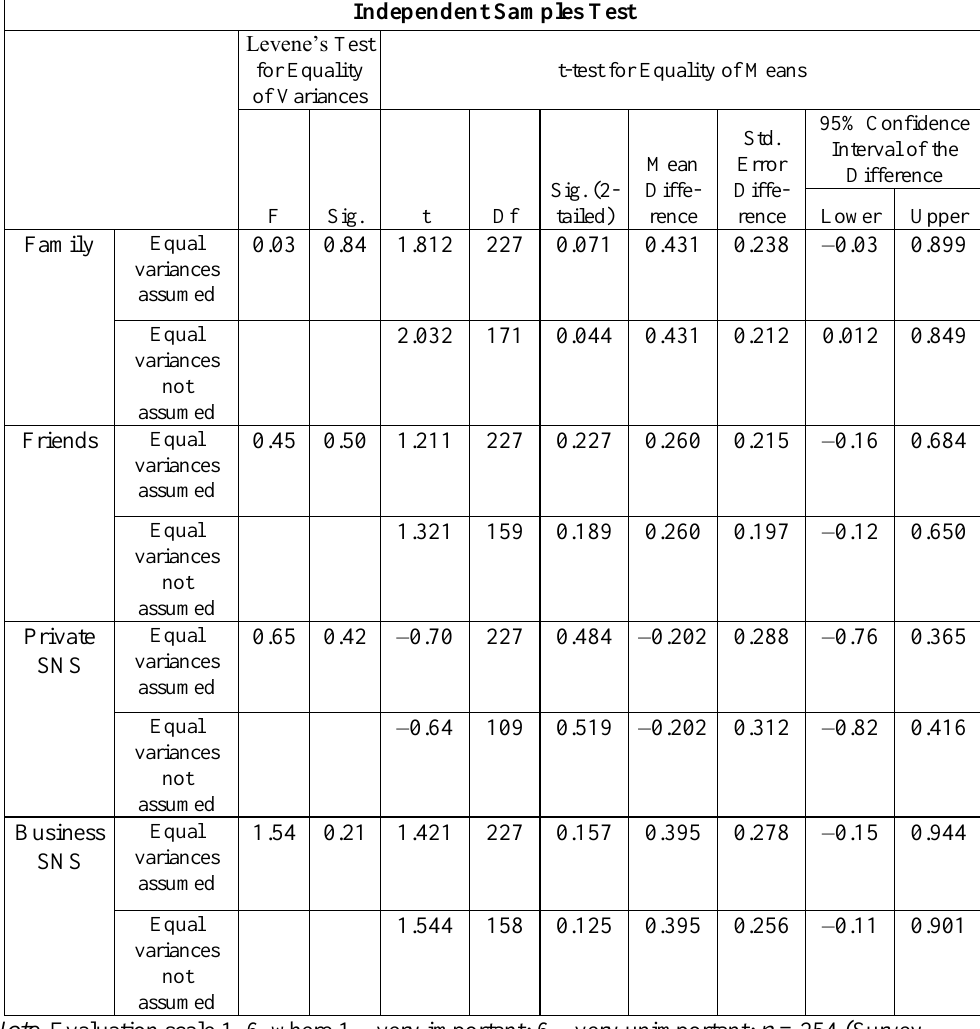
Table 3. Analysis of Evaluations of Different Social Networks by Gender to the question “How important is it for you that other people are informed about